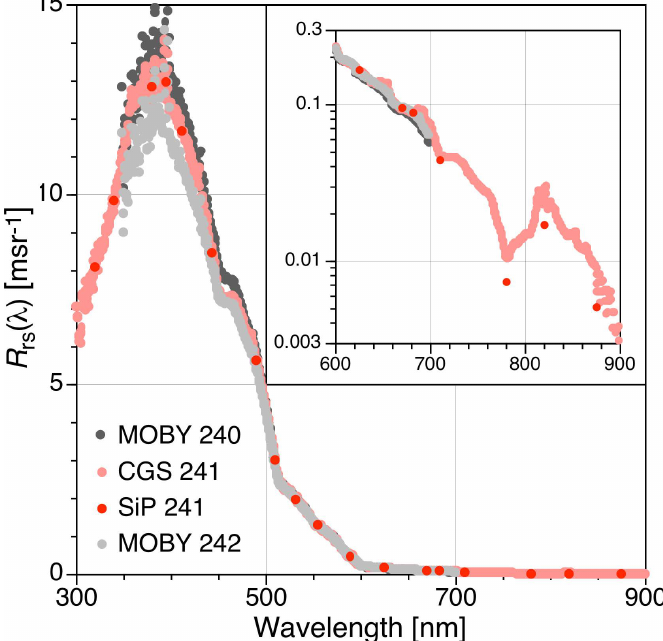
Figure 3. A verification comparison of MOBY hyperspectral R rs ( λ ) data, spanning approximately 350–700nm and in units of inverse millisteradians (msr − 1 ). MOBY data were obtained before and after severe weather on SDY 241 (28 August 2016) with corresponding C-PHIRE hyperspectral CGS and multispectral SiP data products derived from SV3 TOW-FISH profiles on SDY 241 in a nearby lee located on southwest coast of Lana’i. The smaller inset panel provides a logarithmic display of Red and NIR data spanning 600–900nm with the same axis units as the larger panel. The number of comparisons was limited by passage of typhoons Madeline and